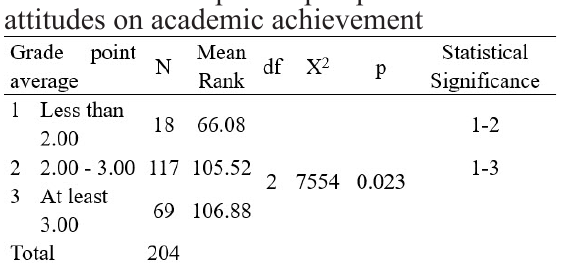
Table 10 . Impact of most widely